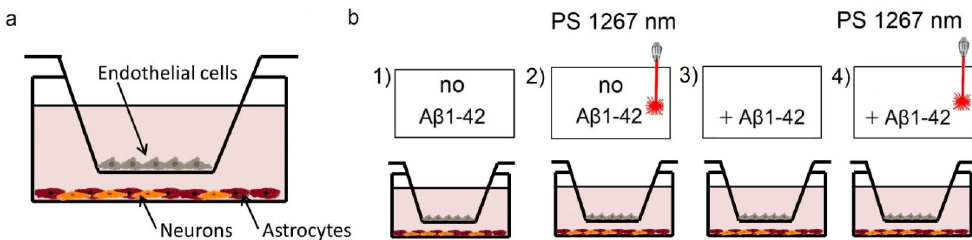
Figure 1. Schematic illustration of a three-cell model of a neurovascular unit (NVU)in vitro: ( a ) the cultivation and differentiation of cells of NVU: the formation of a monolayer of astrocytes occurs in 7–9 days; for neurons, in 10–14 days; and for endotheliocytes, in 7 days; ( b ) the experimental